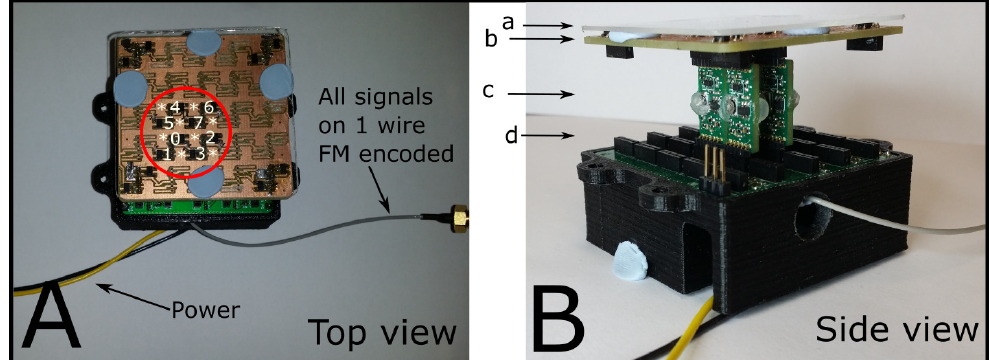
10 × 10 matrix test rig. Channels are numbered from 0 to 7 and have carrier frequency of 8, 11, 14, 17, 20, 23, 26, 29 kHz respectively. * represents virtual sensors used to complete the 4 × 4 taxel elements calculated as intensity average of neighbors after decoding. ( B ) side view. ( a – d ) Protection layer, sensor and connection board, encoding boards, and mixing board,